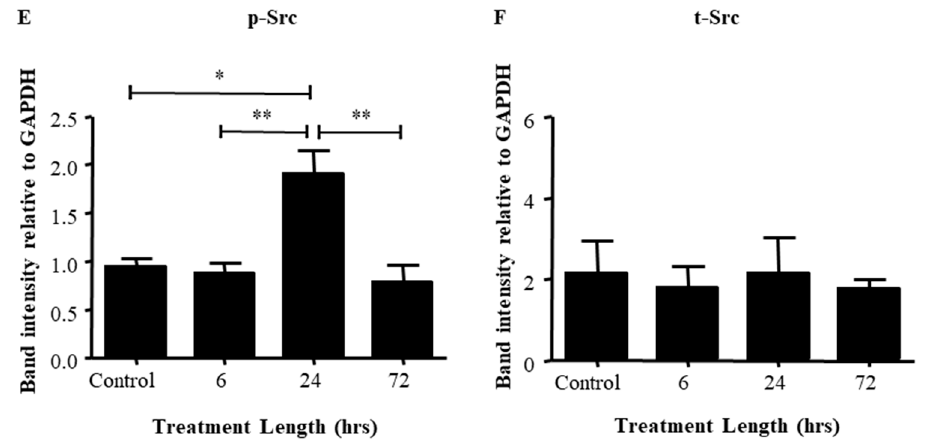
Figure 2. Exposure of HEY cells to paclitaxel enhances phosphorylation of Src in a time dependent manner. ( A ) The expression of p-Src and t-Src was assessed by immunofluorescence in untreated and paclitaxel (0.05 µ g/mL) treated cells following 6, 24 or 72 h of incubation. Staining was visualized using the secondary Alexa 590 (red) fluorescent-labelled antibody, and nuclei were detected by DAPI (blue) staining. Magnification 400 × scale bar = 250 µ m. Quantification of ( B ) p-Src and ( C ) t-Src fluorescent intensities were conducted using Fiji software. Results are displayed as the percentage of the average fluorescent intensity relative to untreated cells ± SEM ( n = 3/group). ( D ) Total cell lysates of HEY cells were collected at 6, 24 and 72 h after paclitaxel treatment and were subjected to immunoblot analysis using antibodies specific for p- or t-Src or GAPDH. Images are representative of three independent experiments. Densitometry analysis of ( E ) p-Src and ( F ) t-Src protein expressions. The values represent the relative mean of band intensity normalized to GAPDH loading control ± SEM. Significance is indicated by * p < 0.05, ** p < 0.01. The patterns of p-Src expression in response to paclitaxel in TOV-21G cells showed Src